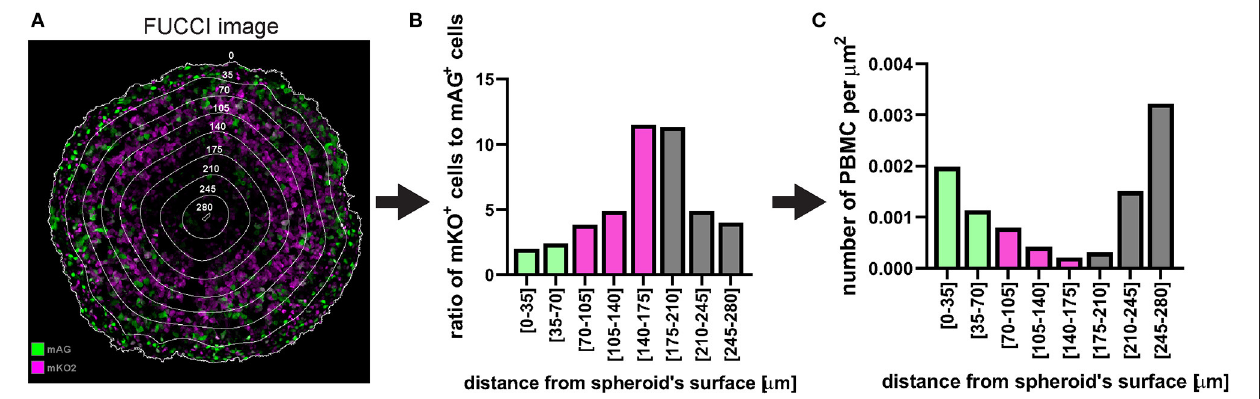
FIGURE 14 | Example of application of fluorescent spheroid-infiltrating PBMC spatial detection analysis. (A) FUCCI fluorescence image of the same spheroid section as in Figure 12 with the same distance rings. A mixture of mAG and mKO2 positive cells designates areas of proliferation whereas G1-arrest occurs in zones with increased proportion of mKO2 positive cells. (B) Ratio of mKO2 positive cells to mAG positive cells plotted as a function of the distance from the spheroid surface. When this ratio is low it indicates proliferation and when it increases it implies occurrence of G1-arrest. Bar colours were assigned based on visual inspection of (A) . Green, proliferation; magenta, G1-arrest; and grey, cell death. Decreased ratio in the necrotic core may be an artefact due to dead cells loosing FUCCI fluorescence. (C) Same PBMC infiltration profile as in Figure 12F where bars (spatial bins) have been colour-coded according to the heterogeneous cell populations identified in (A,B)